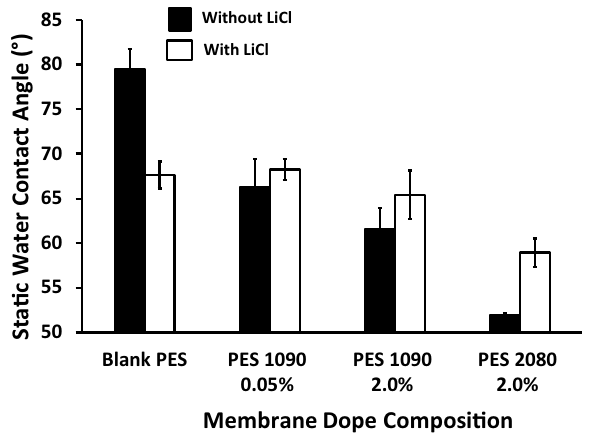
Figure 8. The static water contact angle of the blank PES and the different magnetic mixed matrix PES membranes composition in case of without (black bars) and with (white bars) using 0.1 wt% of Lithium chloride in the membrane